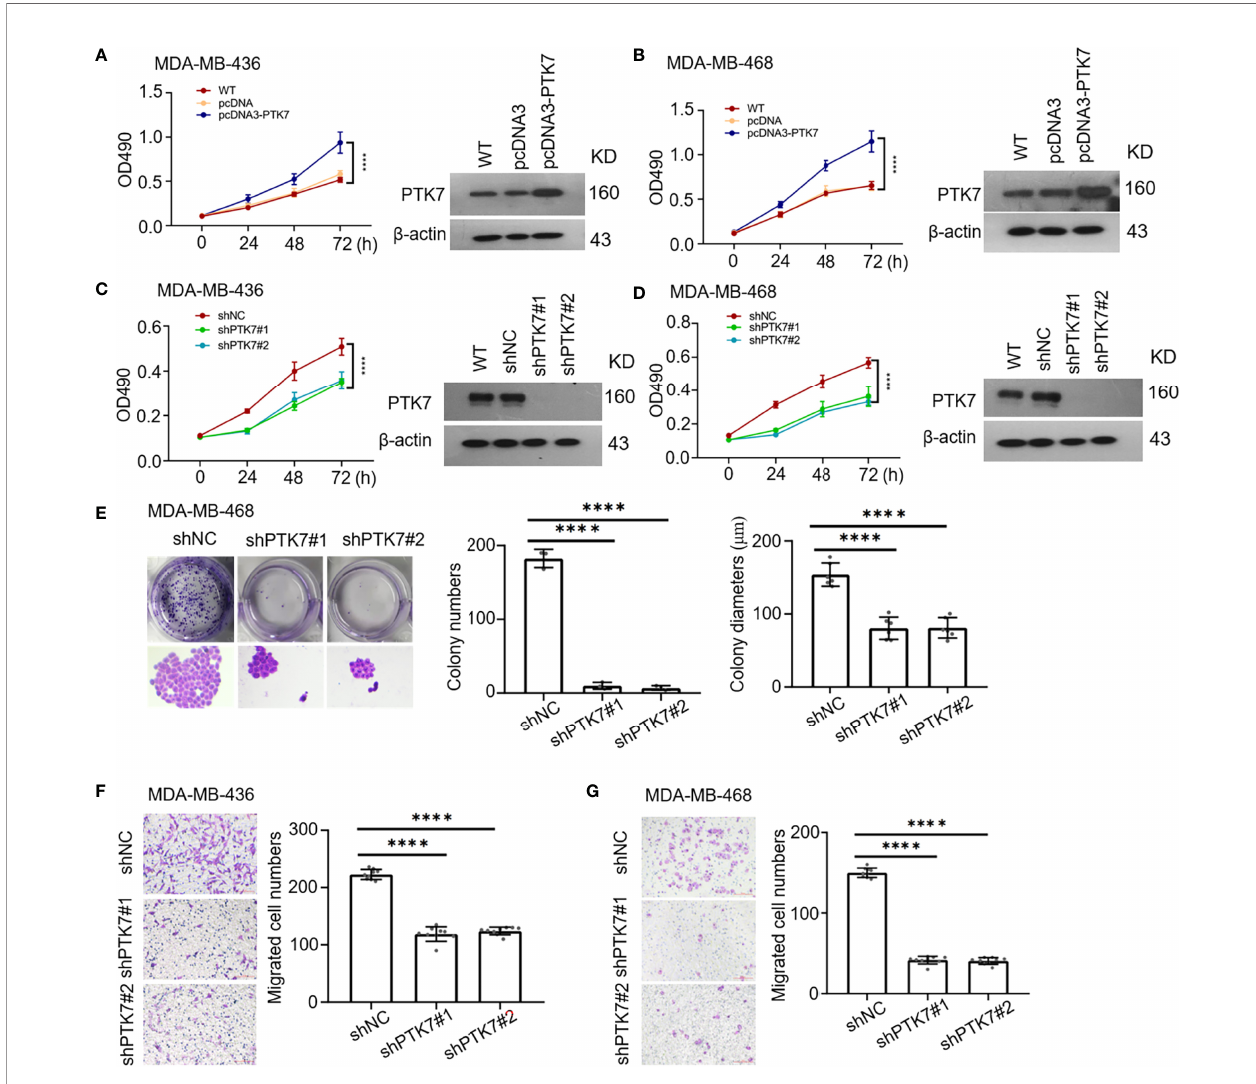
FIGURE 6 | PTK7 participates in cell proliferation and migration in TNBC cell lines. (A, B) TNBC cell lines MDA-MB-436 (A) and MDA-MB-468 (B) were transfected with control vector pcDNA3 or PTK7 expression vector pcDNA3-PTK7 for 48 h and proliferation was evaluated using MTT assay. Data are shown as mean ± s.d. **** P < 0.0001. (C, D) MDA-MB-436 (C) and MDA-MB-468 (D) were transduced with a non-targeting control shRNA (shNC) or two different PTK7-speci fi c shRNAs (shPTK71 and shPTK7#2). Cell proliferation was evaluated using MTT assay. Data are shown as mean ± s.d. **** P < 0.0001. (E) Colony formation assay was performed to determine proliferation in shNC-, shPTK7#1- or shPTK7#2-transduced MDA-MB-468 cells. Presentative images are shown (left) and colony numbers and colony diameters were shown as mean ± s.d. Magni fi cation, ×100; **** P < 0.0001. (F, G) Transwell migration assay using Boyden chamber in